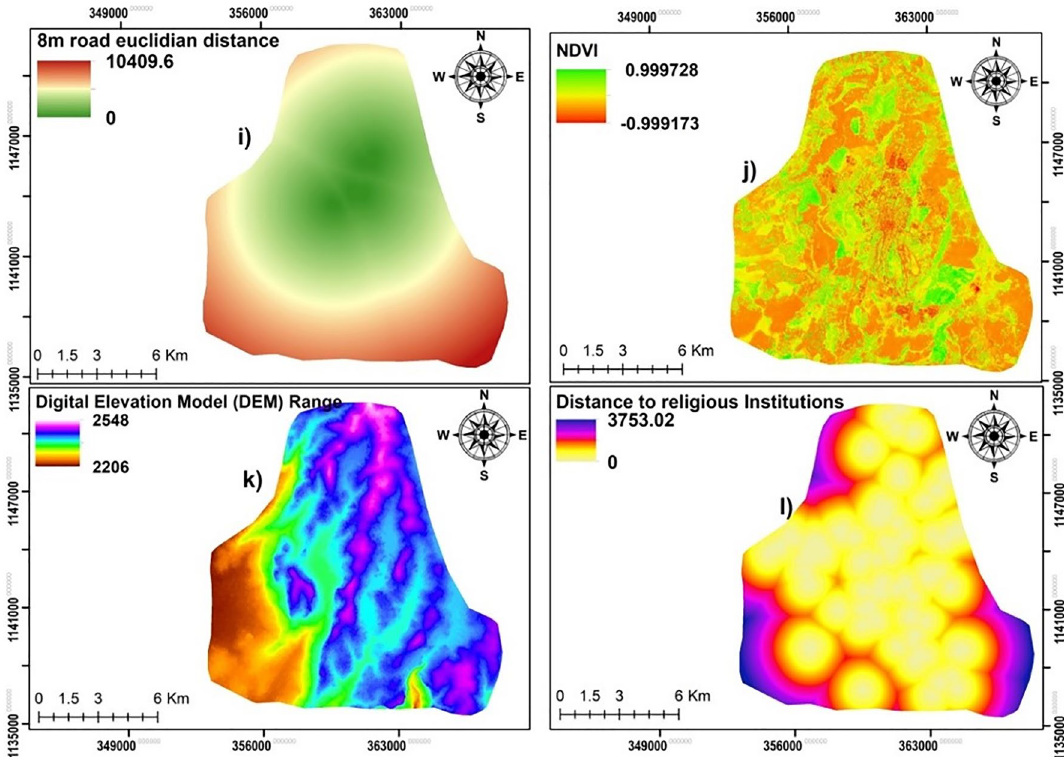
Fig. 5 Proximity to road distance i 8 m j NDVI k the minimum and maximum value of digital elevation model (DEM) l distance to the religious